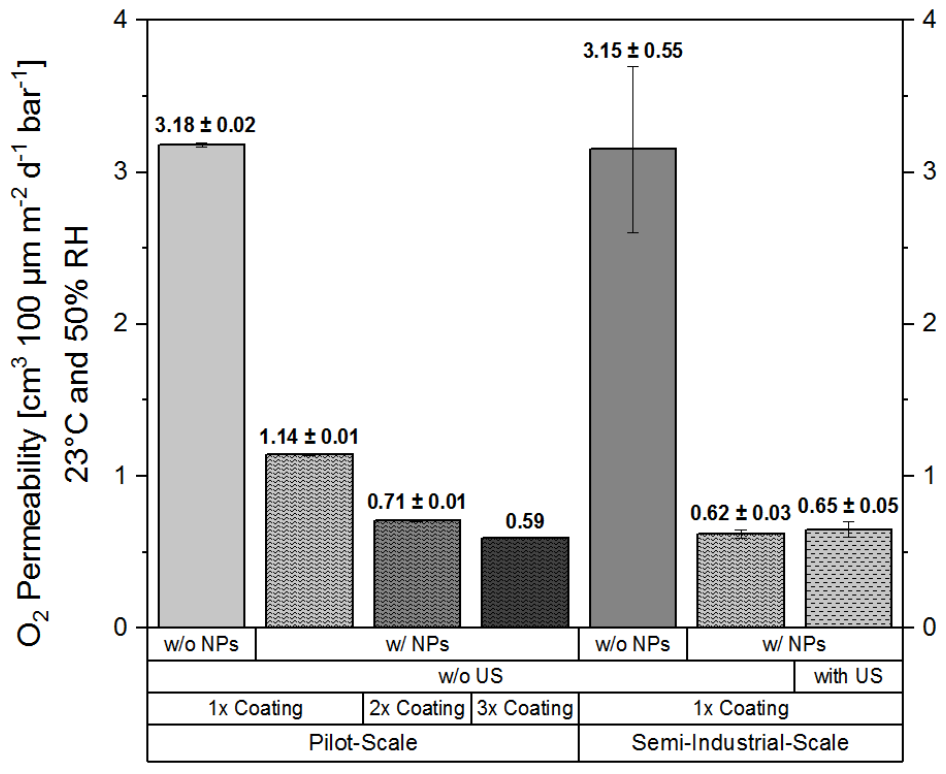
Figure 2. Oxygen permeability (Q 100 at 23 °C and 50% RH of WPI-based coatings calculated for a coating layer thickness of 100 µm. Effects of nanoparticle (NP) addition, number of coating/drying steps (1×, 2×, and 3× coating), ultrasound treatment (US, with and without (w/o)), and manufacturing environment (pilot-, semi-industrial-scale) on the WPI-based coating formulations prepared using novel ready-to-use agglomerates are shown. The data shown represent mean values of a two-fold measurement ± minimum/maximum deviation (range of variation).